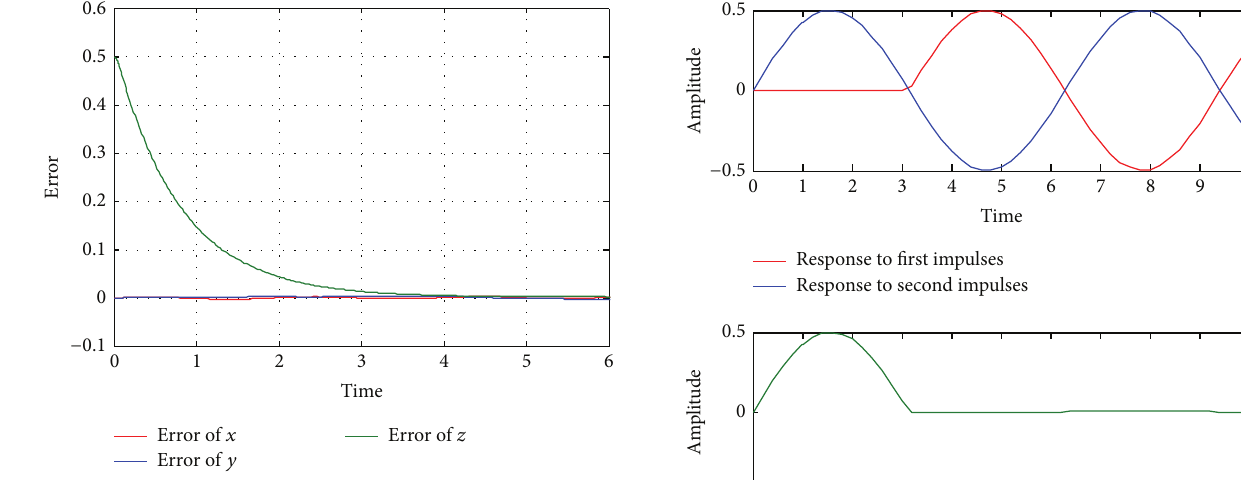
Figure 11: Position error of quadrotor in circle flight with MBA controller.